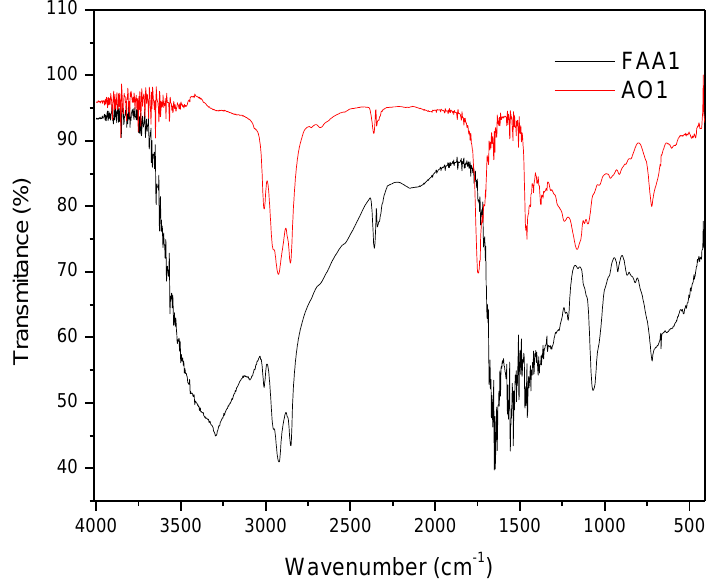
Figure 1. Fourier transform infrared analysis- FT-IR spectra of the sample from andiroba oil- AO 1 (red line) and fatty acid amides- FAA1 (black line).